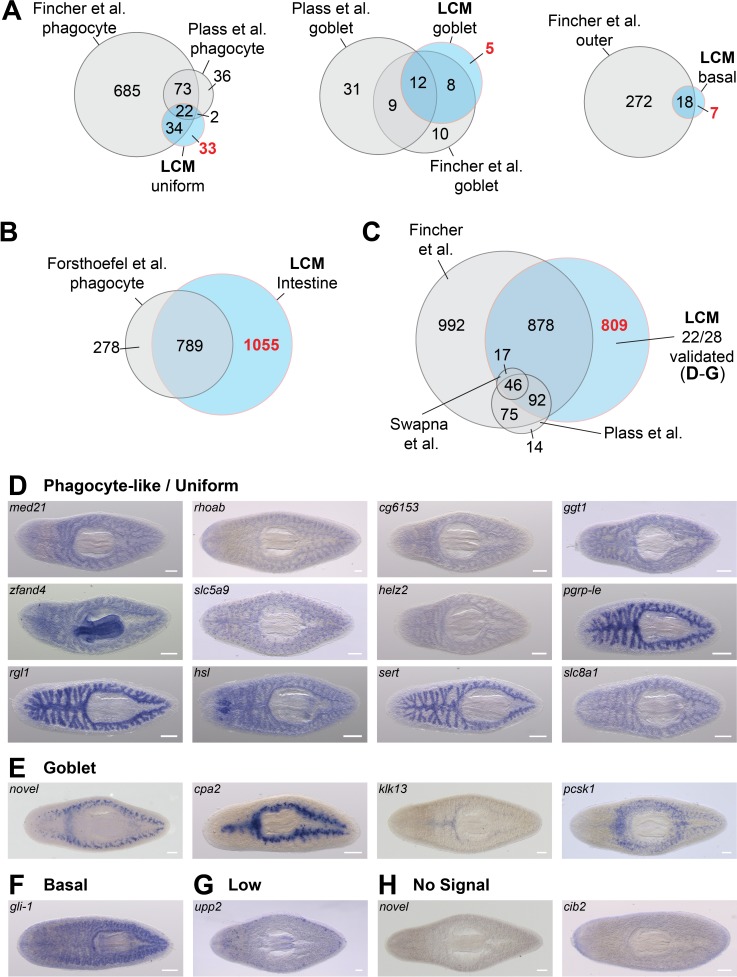
LCM-RNA-Seq identifies additional intestine-enriched transcripts.(A) Venn diagrams compare intestine-enriched transcripts identified in three scRNA-Seq studies (Fincher et al., 2018; Plass et al., 2018; Swapna et al., 2018) and this study, grouped by assignment to cell type (scRNA-Seq studies), or by uniform/phagocyte-like, goblet cell, and basal cell WISH expression patterns (this study). (B) Comparison of transcripts enriched in sorted phagocytes (Forsthoefel et al., 2012) with orthologs in the dd_Smed_v6 transcriptome, and laser-captured intestine. (C) Overlap between all intestine-enriched transcripts (based on RNA-Seq data) in three recent single-cell studies and our LCM data. Overlaps of two or fewer genes are not displayed. (D) Examples of intestine-enriched transcripts with a uniform/phagocyte-like expression pattern (WISH) identified by LCM-RNA-Seq, but not in other studies. (E) Examples of intestine-enriched transcripts with expression in goblet cells (WISH) identified by LCM-RNA-Seq, but not in other studies. (F) Example of intestine-enriched transcript expressed in basal cells (WISH) identified by LCM-RNA-Seq, but not in other studies. (G) Intestine-enriched transcript with low expression identified in this study. (H) Examples of transcripts enriched in LCM-RNA-Seq data for which expression was undetectable by WISH (e.g. did not validate). Detailed numerical data are in Supplementary file 1 and Figure 2—source data 1. Scale bars, 200 μm.